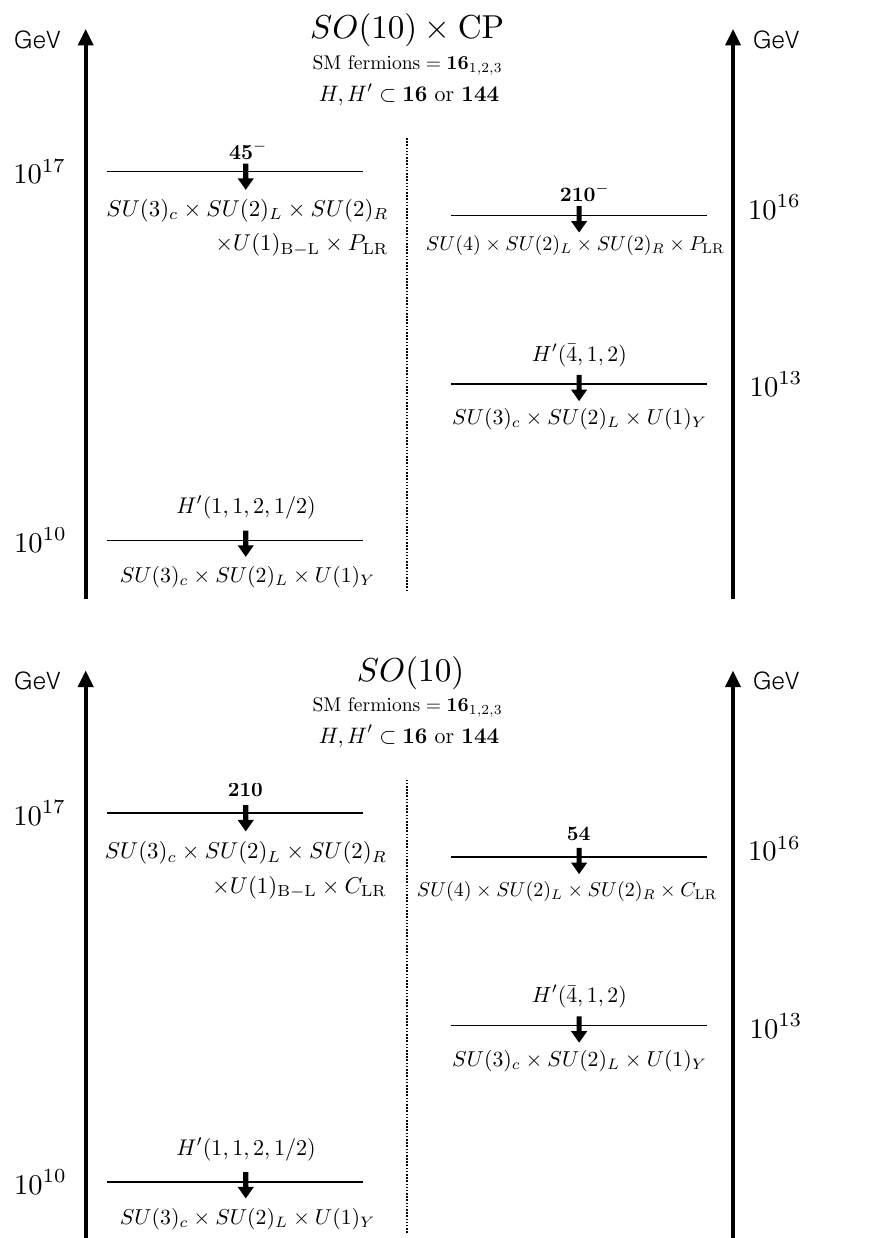
Figure 4 . The symmetry breaking of SO(10) CP to the SM gauge group that solves the strong (cid:2) CP problem and explains the vanishing quartic coupling (top). The symmetry breaking of SO(10) to the SM gauge group can also explain the vanishing quartic coupling